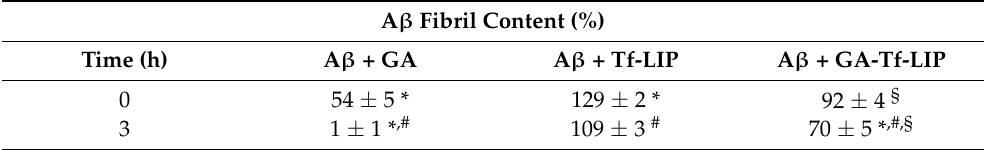
Table 4. Amount of A β 1-42 fibrils upon their incubation with GA, unloaded, and GA-loaded Tf- functionalized liposomes for 3 h at 37 ◦ C. * Indicates a statistical difference compared to untreated A β fibrils ( p < 0.05). # Indicates a statistical difference between the beginning and end of the experiment ( p < 0.05). § Indicates a statistical difference between unloaded and GA-loaded Tf-liposomes ( p < 0.05). A β Fibril Content